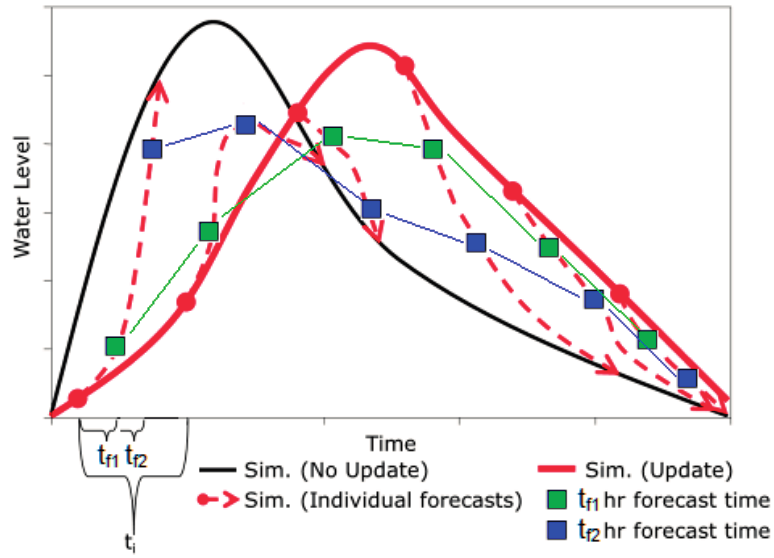
Figure 2. Sketch of how the forecasting time series is produced. The black and red solid curves represent simulation results when the model is run without and with updating, respectively. The dashed curves represent simulation results from a model run with updating (red solid curve) until the dot, after which the simulation continues without updating. The time between these dots ( t ) is the time step of the forecast time series, and the squares i connected with thin lines represent points in the t hour forecast time series. Two examples of f forecast time series are shown, for a short (t , green squares) and a long (t , blue squares) f1 f2 forecast